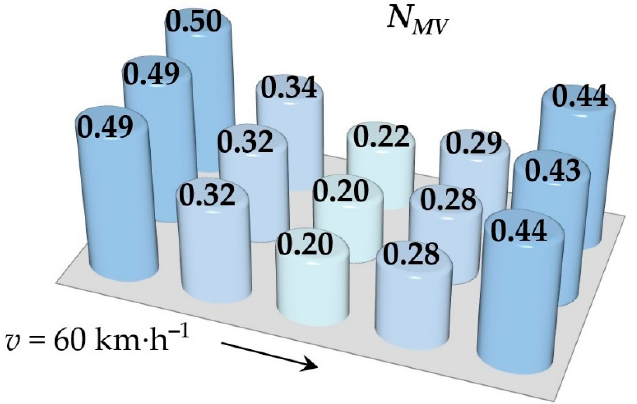
Figure 9. The distribution of the index N MV for a speed of 60 km ∙ h − 1 : the “Original” parameters.